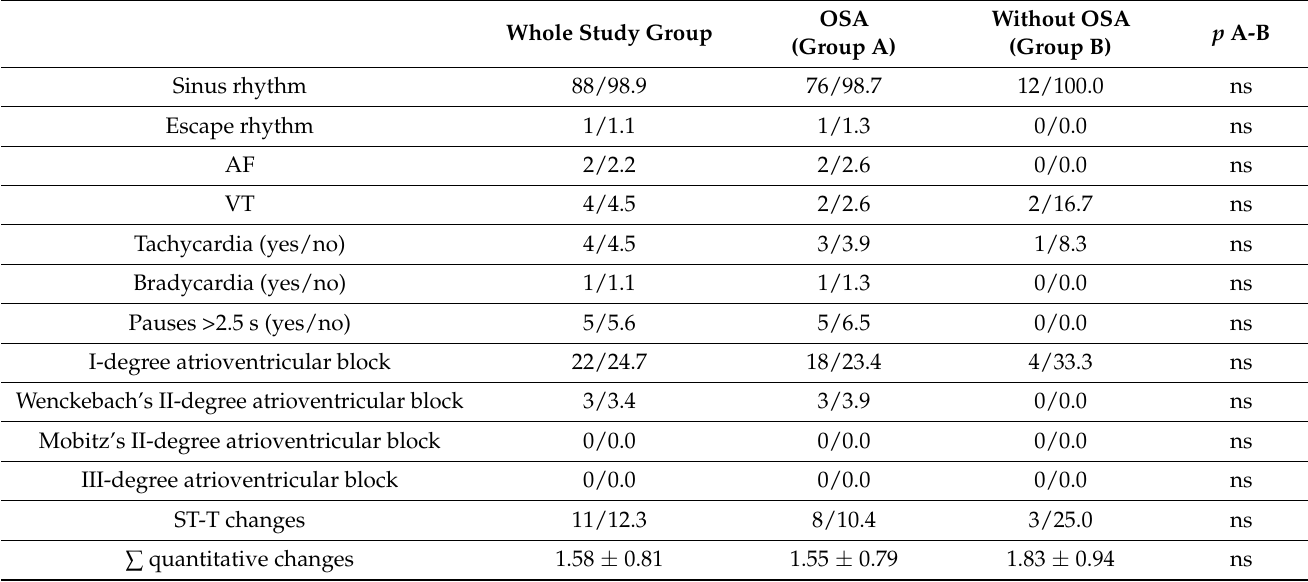
Table 3. Qualitative parameters of 24-h ECG Holter monitoring in the studied group of patients.